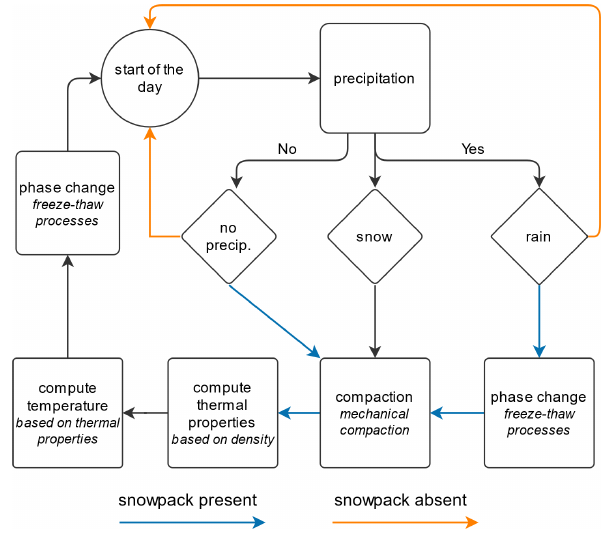
Figure 2. Steps in the daily computational cycle for the Dynamic snow scheme. Blue arrows indicate workflow in case a snowpack is present on the ground, while orange arrows show steps when a snowpack is